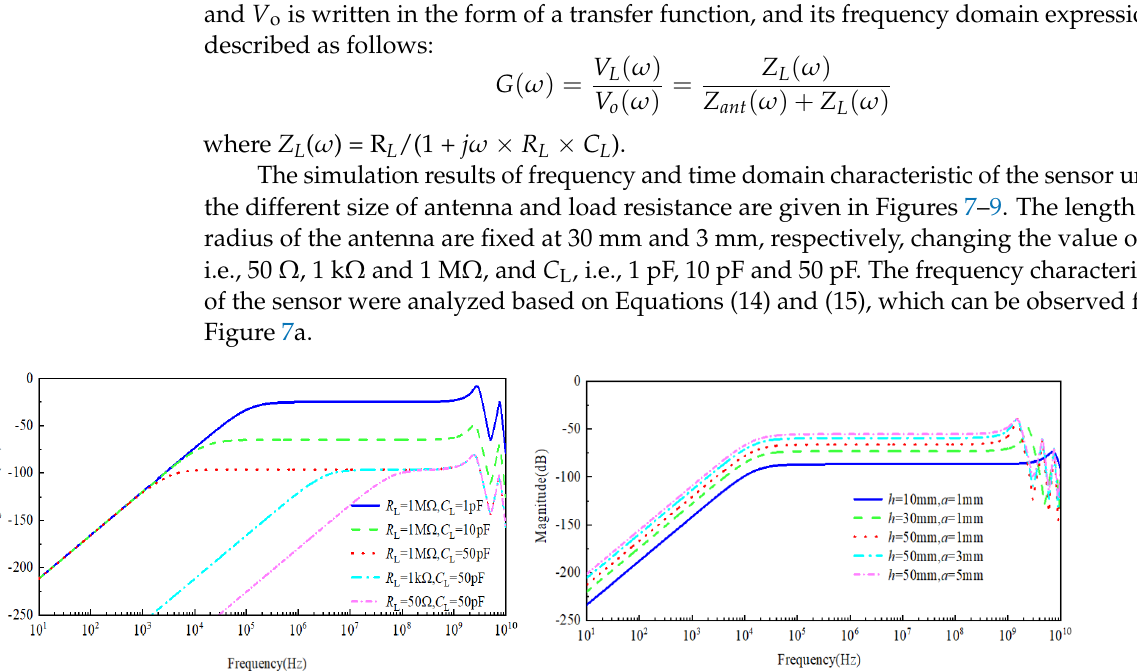
Sensors 2021 , 21 , x FOR PEER REVIEW